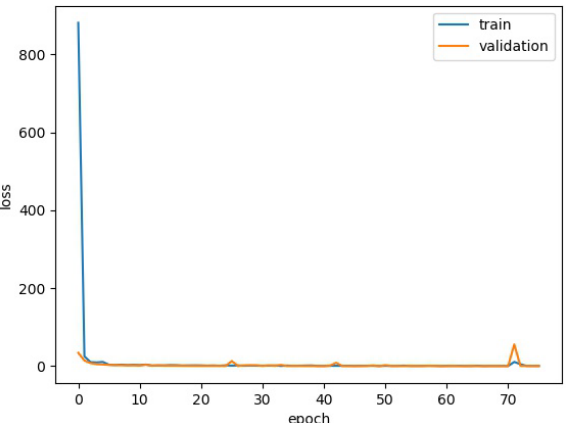
Figure 4. Training loss and validation loss in the training process.